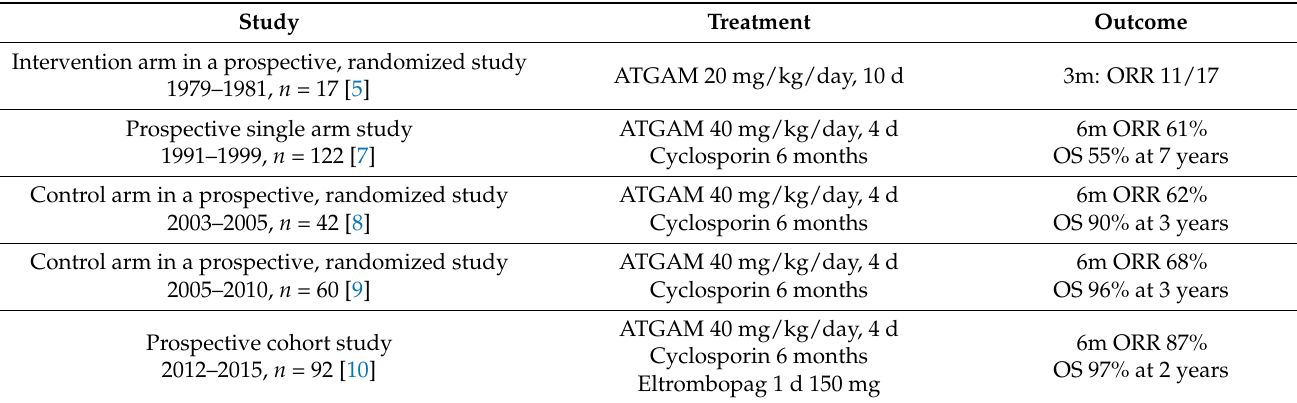
Table 1. Published prospective studies on ATGAM as first line therapy in acquired AA. d: days, ORR: overall response rate, OS: overall survival.